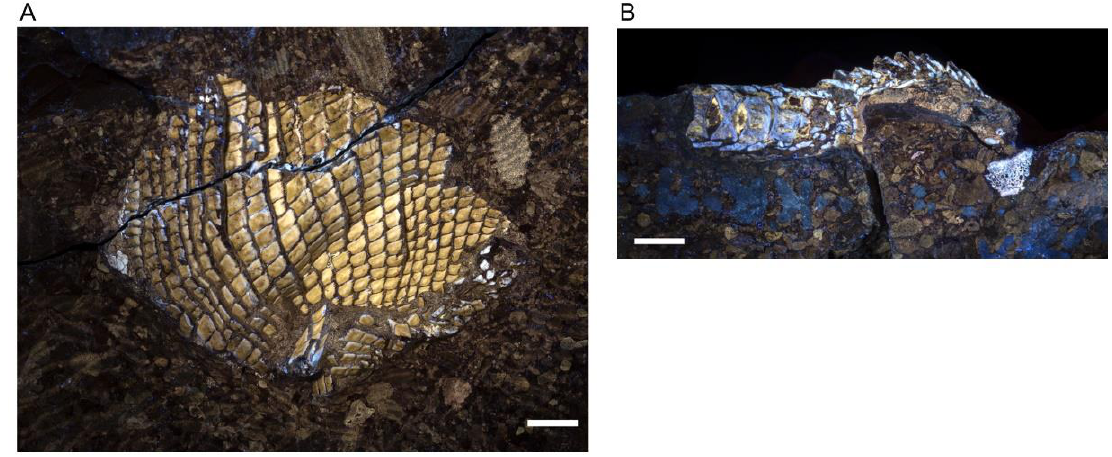
Figure 7. Paratype of Khoratamia phattharajani gen. et sp. nov., NRRU-F01020024: ( A ) specimen photographed under UV light; ( B ) series of vertebra column imaged with UV light. Scale bar: 1 cm.